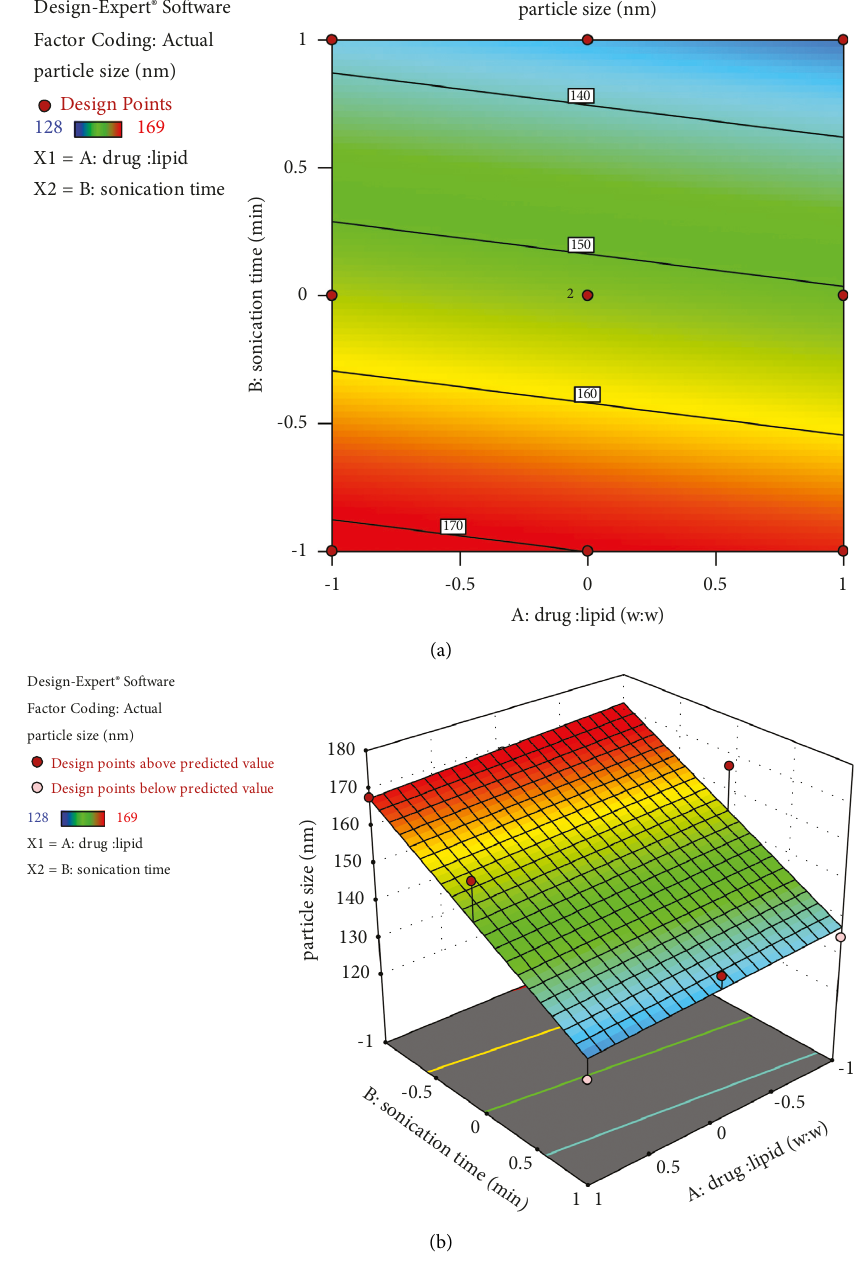
Figure 1: (a) Contour plot of particle size (nm) against drug: GMS ratio (w:w) and sonication time (min) and (b) 3D surface plot of particle size (nm) against drug: GMS ratio (w:w) and sonication time